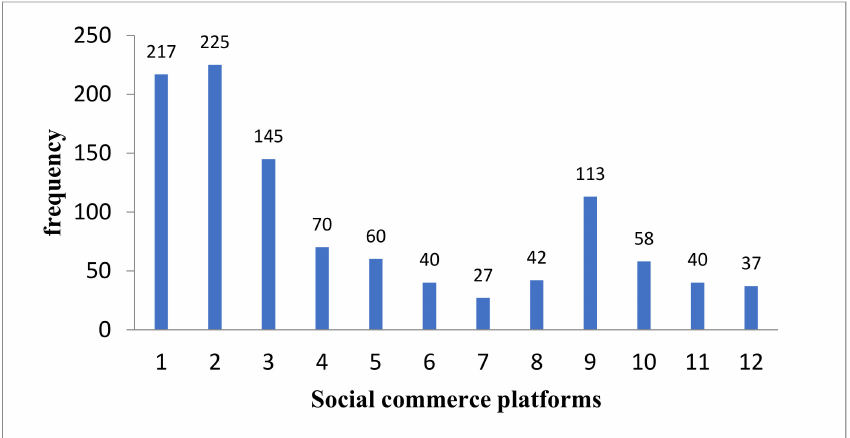
Figure 2. Distribution of social commerce platforms. 1 = Dianping; 2 = Xiaohongshu; 3 = Dewu; 4 = Mogujie; 5 = Meilishuo; 6 = Hers; 7 = Xiaohongchun; 8 = Kwaishop; 9 = Douyinec; 10 = Meiyou; 11 = Fensii; 12 =